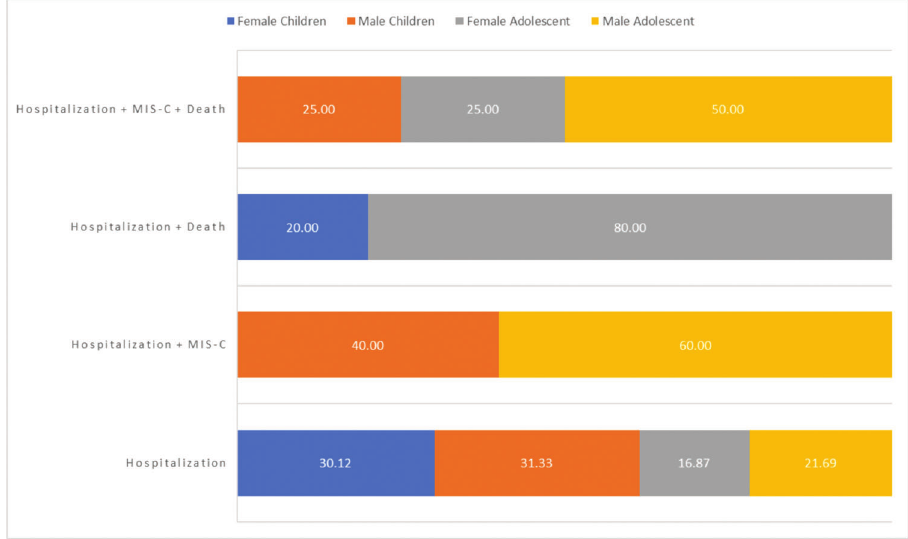
Figure 1 - Demographic data and outcomes in children (aged o 10 years) vs. those in adolescents (aged X 10 years) with laboratory- confirmed coronavirus disease 2019 (COVID-19) . MIS-C, multisystem inflammatory syndrome in children; hospitalization + MIS-C +